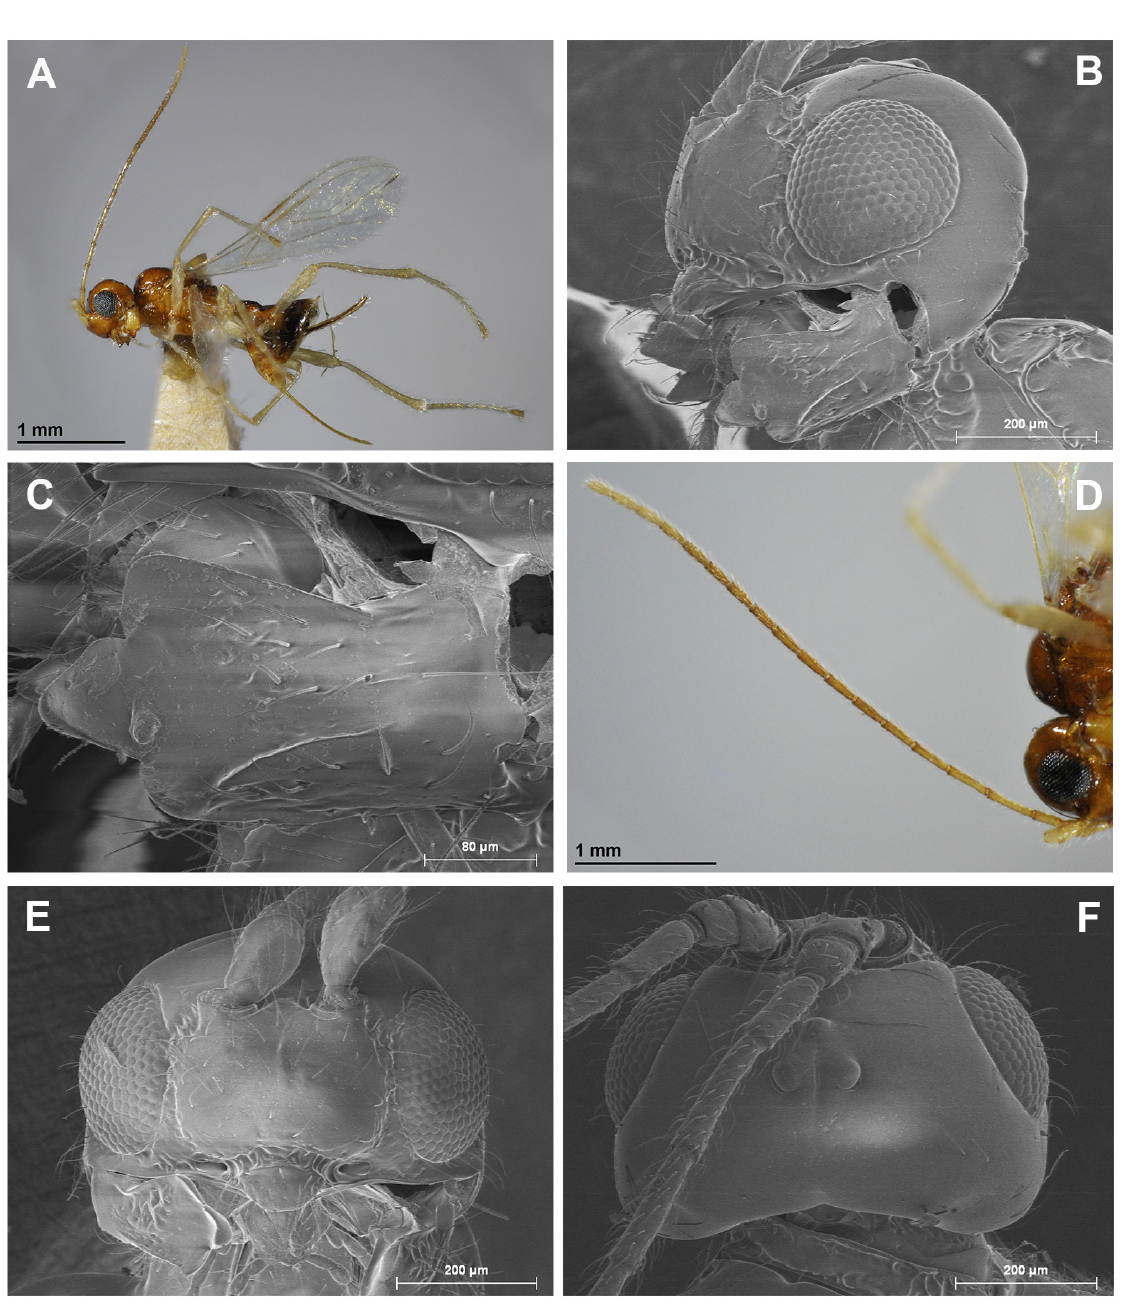
Fig. 15. Asobara epiclypealis Fischer, 2003, ♀, holotype (NHMW). A . Habitus, lateral view. B . Head, lateral view. C . Mandible. D . Antenna. E . Head, front view. F . Head, dorsal